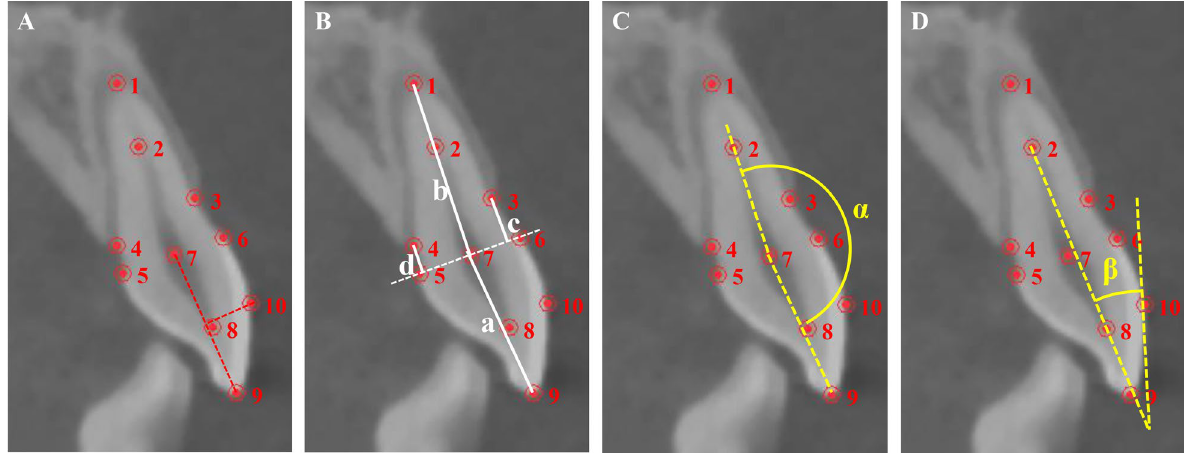
Fig. 1 Measurement of dental anatomic characteristics. A Point identification (1-root apex; 2-point of lower 1/3 root; 3-labial alveolar ridge crest; 4-palatal alveolar ridge crest; 5-palatal cemental-enamel junction (CEJ); 6-labial CEJ; 7-midpoint of labial and palatal CEJ; 8-apex of crown pulp cavity; 9-incisal edge point; 10-projection of midpoint of crown axis on labial surface). B Line distance measurement (a-crown length; b-root length; c-height of labial alveolar bone; d-height of palatal alveolar bone). C Crown-root angle; D Labial surface-axis